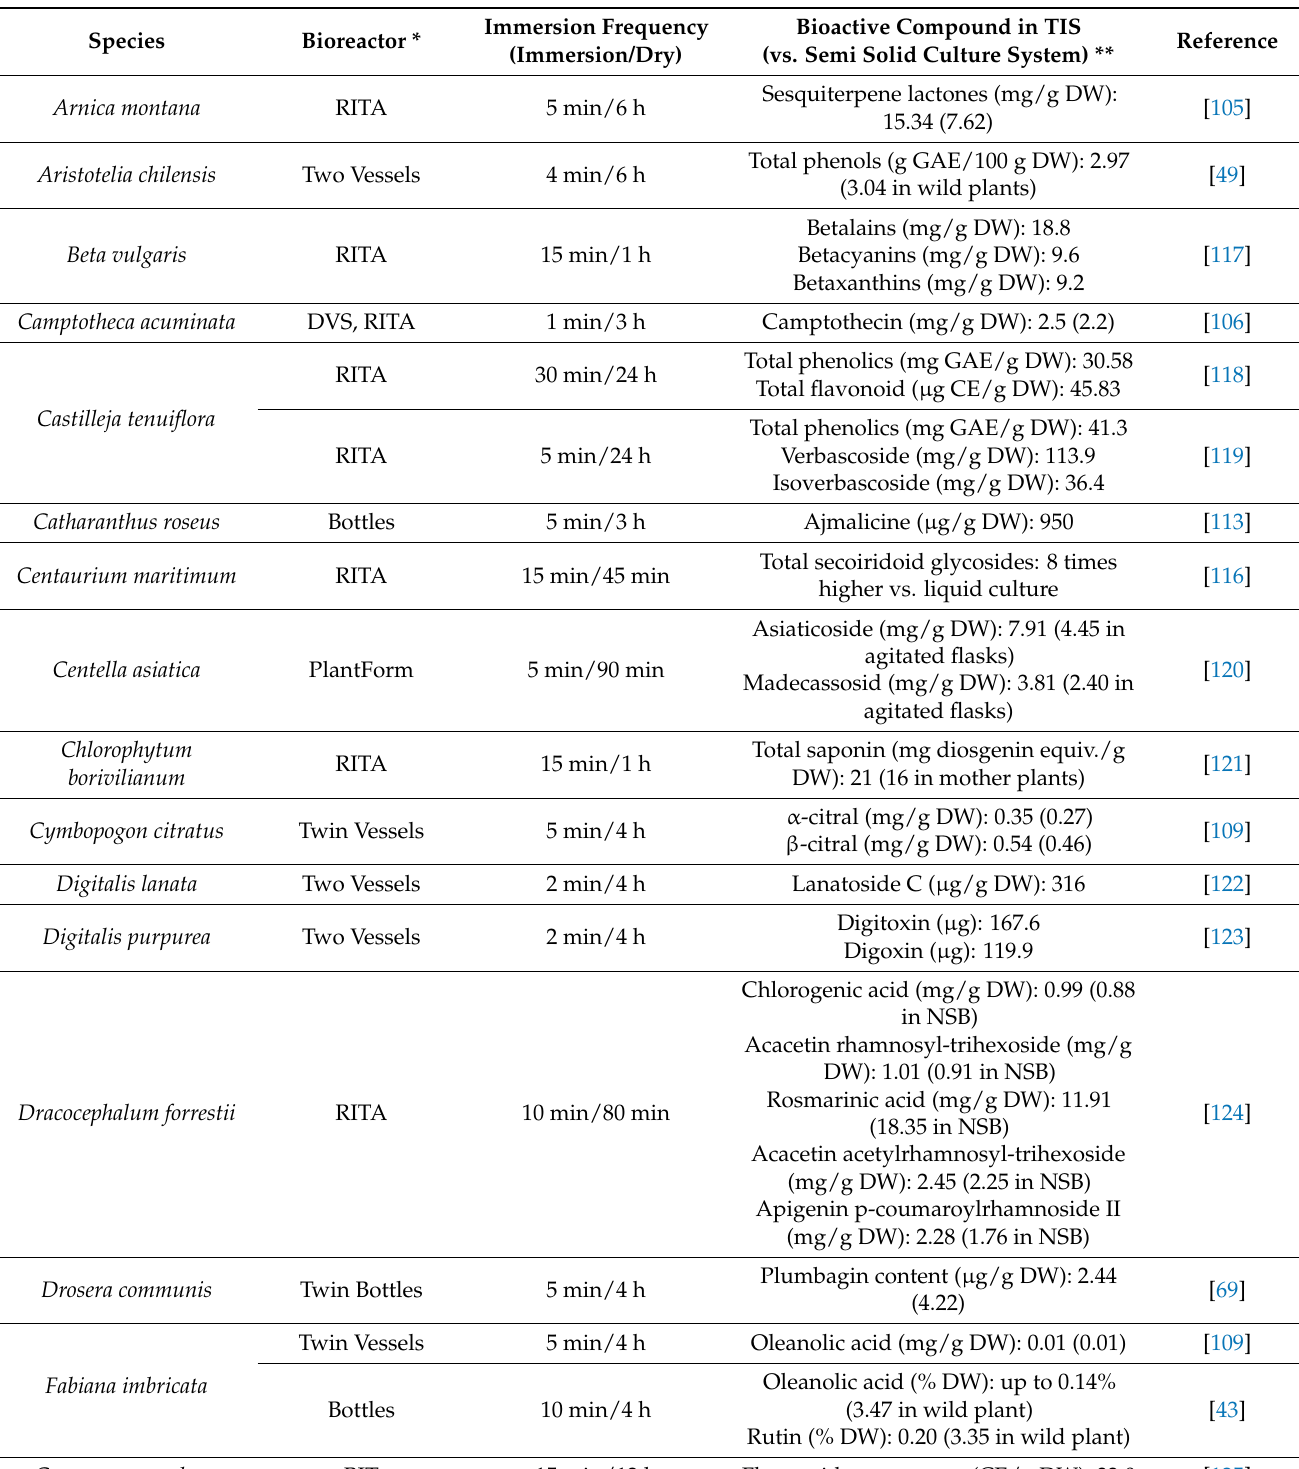
Table 2. Bioactive compounds production in medicinal plants cultured in TIS with different bioreactors and immersion times. Best results are reported for each species (terminology and values are the same as mentioned by the